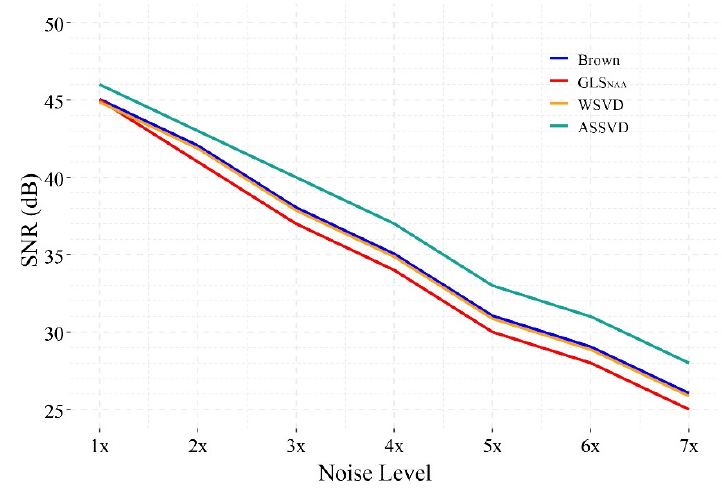
Figure 7. The SNR of different coil-combination results under 1×–7× simulated correlation noise.